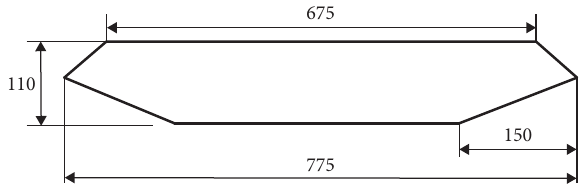
Figure 1: The deck cross section (unit: mm).